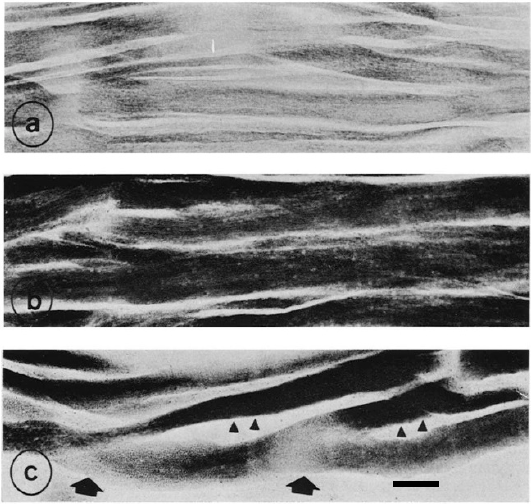
Figure 4. Longitudinal section of succinic dehydrogenase (SDH) activity in: normal ( a ); dystrophic ( b ); and combined (normal + dystrophic) donor muscles ( c ), regenerating in normal host chicks at 56 days post-operation made at 10 days after hatching. The SDH activity in dystrophic fibers is higher than in normal fibers. Compared with homogeneous enzyme reaction in normal and dystrophic donor muscles, SDH activity in combined transplants is more variable along the length, higher (arrowhead) and lower in others (large arrow). Adopted from Kikuchi et al. 1980 [47]. ( c ) Bar = 100 μ m.